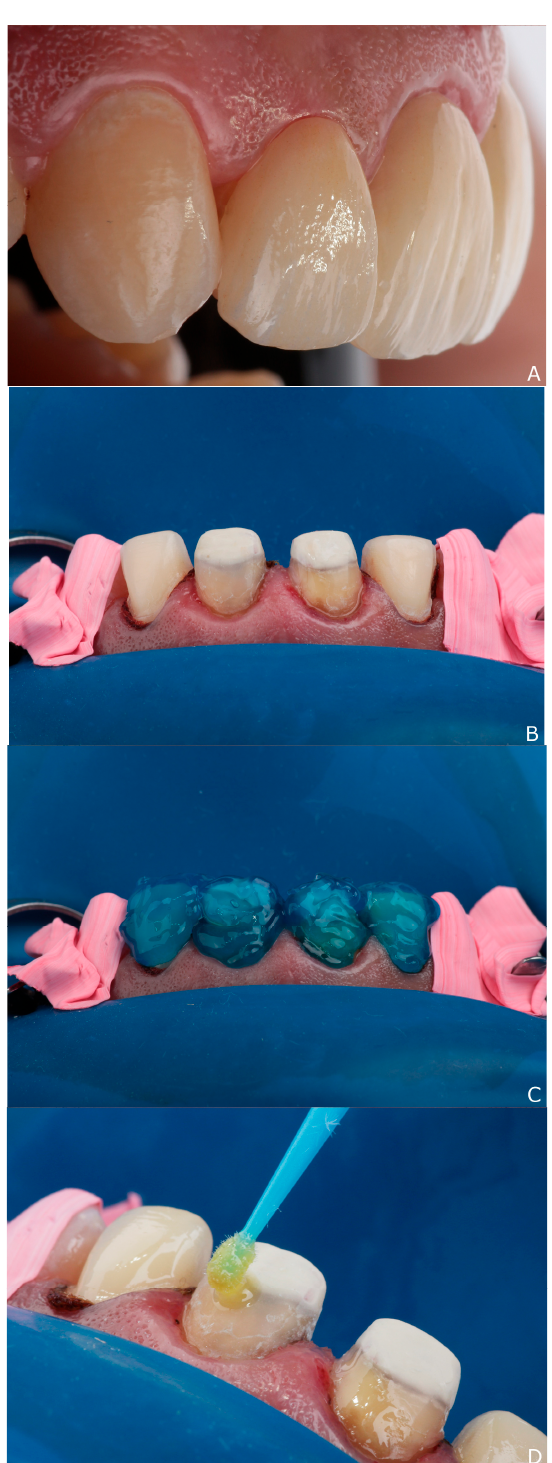
Figure 7. Steps of cementation: ( A ) clinical evaluation of fitting, surface texture and color matching; ( B ) isolation with split dam technique; ( C ) acid etching with 37% phosphoric acid; ( D ) bonding with universal